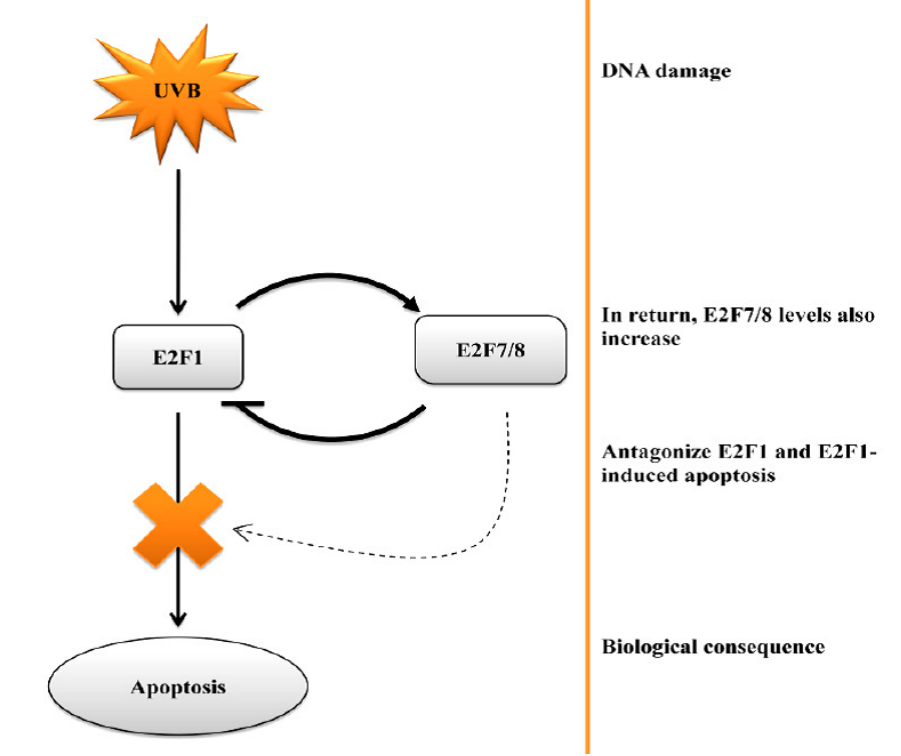
Figure 4. Schematic showing how showing how E2F1 and E2F7 contribute to formation of cutaneous 7 contribute to formation of malignancies due to dysregulated apoptotic control. dysregulated apoptotic control.